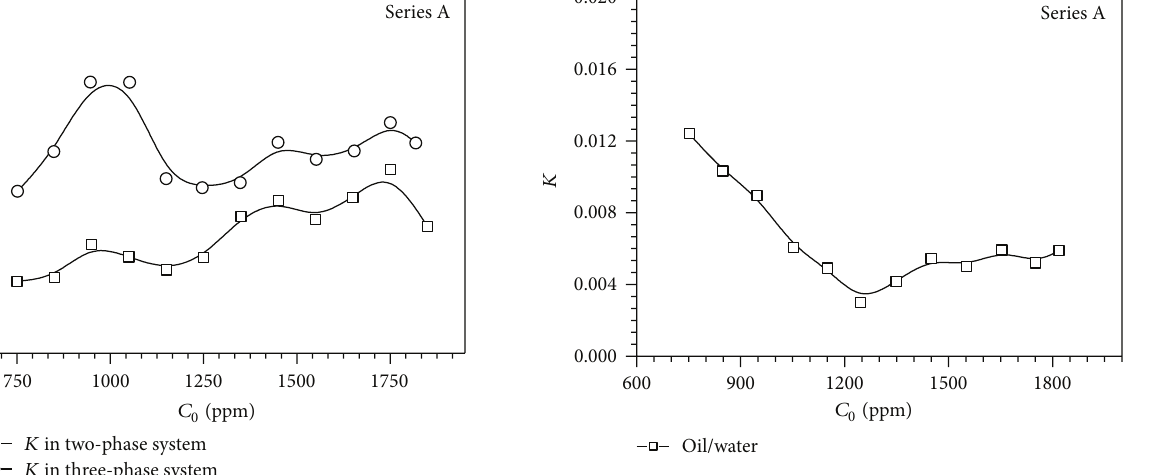
Figure 5: The distribution coefficient in water-sands system in the two-phase and three-phase systems in the simulative water A.